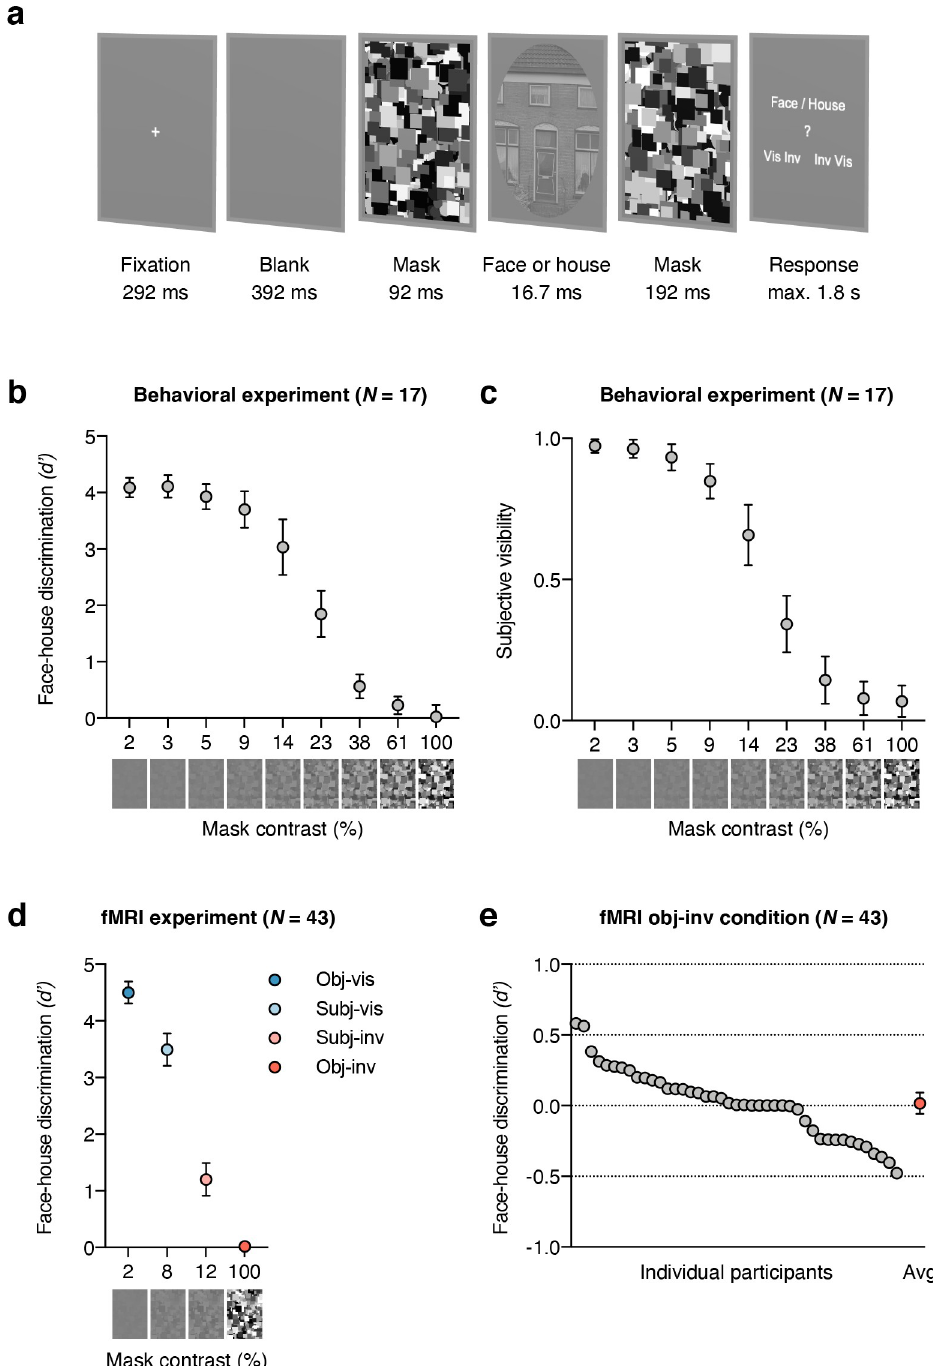
Fig 1. Experimental paradigm, results from the behavioral masking efficiency experiment and behavioral results from the fMRI experiment. (a) Example trial: A face or house stimulus was forward and backward masked by a mask with variable contrast, depending on the visibility condition. On every trial, participants judged both the category and visibility of the masked stimulus, yielding measures of objective category discriminability and of subjective stimulus visibility. (b) Results from the behavioral masking efficiency experiment. Mean face-house discriminability is plotted for 9 different masking contrast levels (on a log 10 scale). Only with 100% masking contrast did discriminability not significantly exceed chance performance. (c) Mean visibility ratings from the behavioral masking efficiency experiment. (d) Behavioral results from the fMRI experiment. Mean face-house discriminability is shown for the four